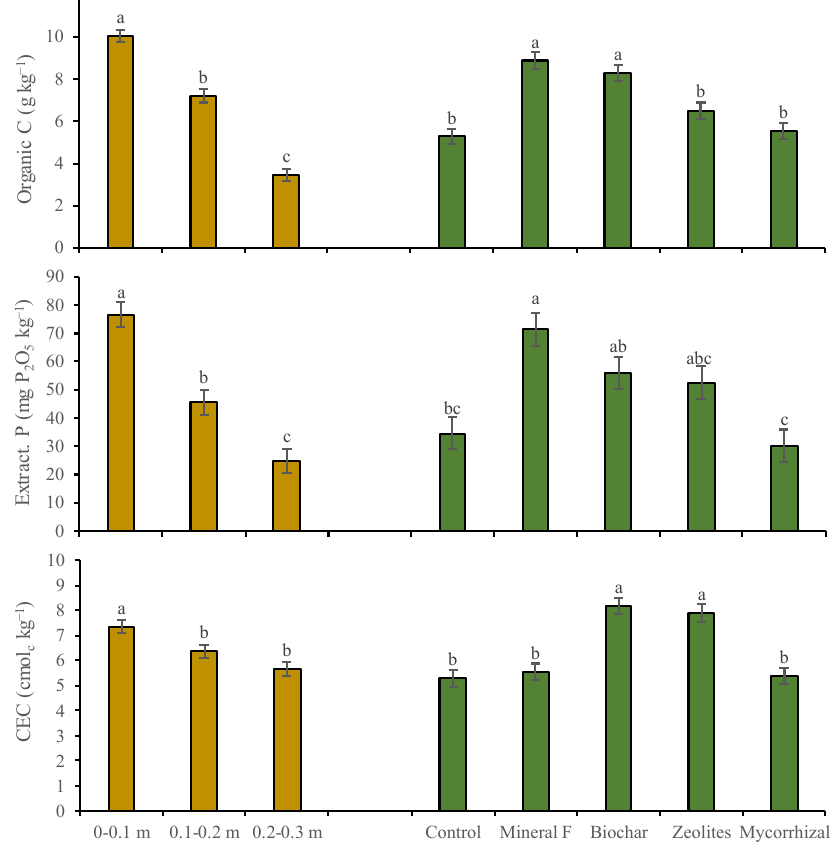
Figure 7. Organic carbon (C), extractable phosphorus (P) and cation exchange capacity (CEC) as a function of soil depth and treatment. Within soil depth and treatment, means followed by the same letter are not significantly different by Tukey HSD test ( α = 0.05). Error bars are the standard errors.